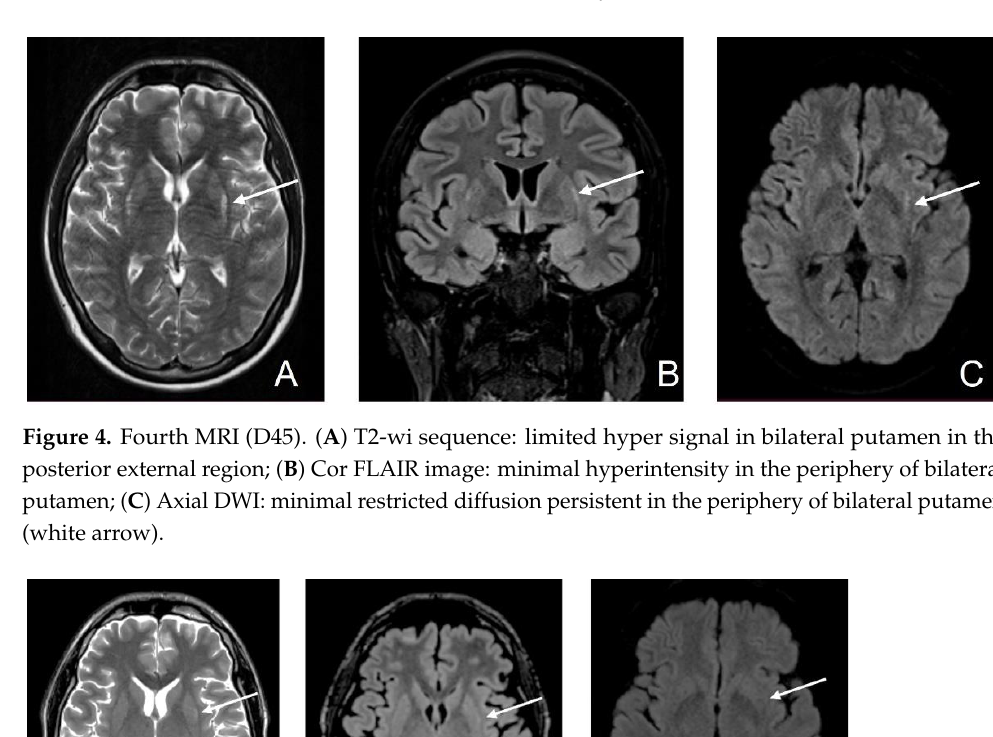
Figure 3. Third MRI—D11. ( A ) Axial T2-wi sequence: persistent high T2 signal intensity in posterior 2/3 of the putamen; ( B ) Axial FLAIR image: Symmetrical hyperintensity of the posterior 2/3 of the putamen (white arrow) and normal signal intensity of the caudate nucleus (yellow arrow); ( C ) Axial DWI: persistent symmetrical moderate restricted diffusion in the posterior 2/3 of the putamen (white arrow) and no restricted diffusion in the caudate nucleus (yellow arrow).